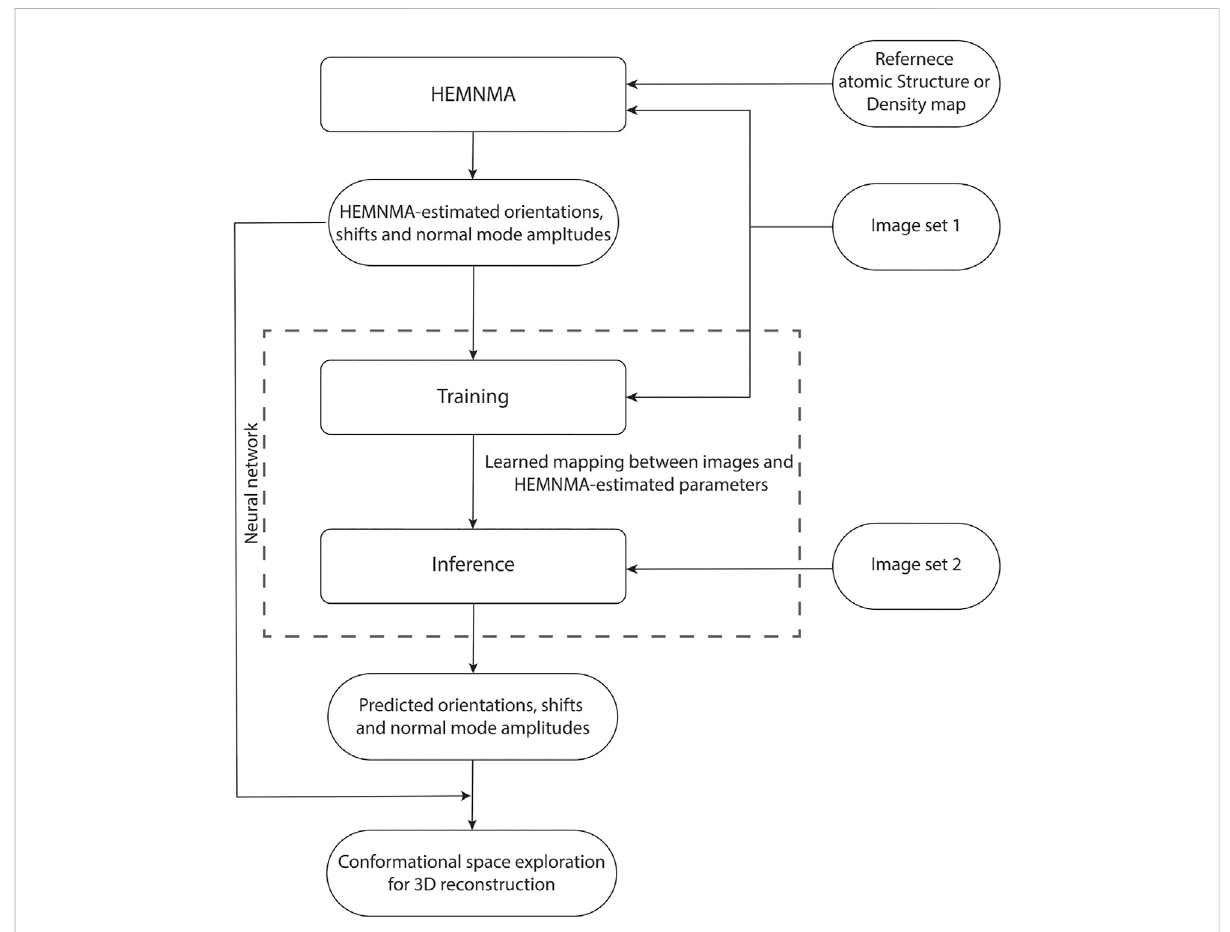
FIGURE 1 Flowchart of DeepHEMNMA combining HEMNMA and deep neural network methods. It uses an input atomic structure or EM map (reference) and an input set of images split into two subsets indicated as Image set 1 (referred to as training set) and Image set 2 (referred to as test